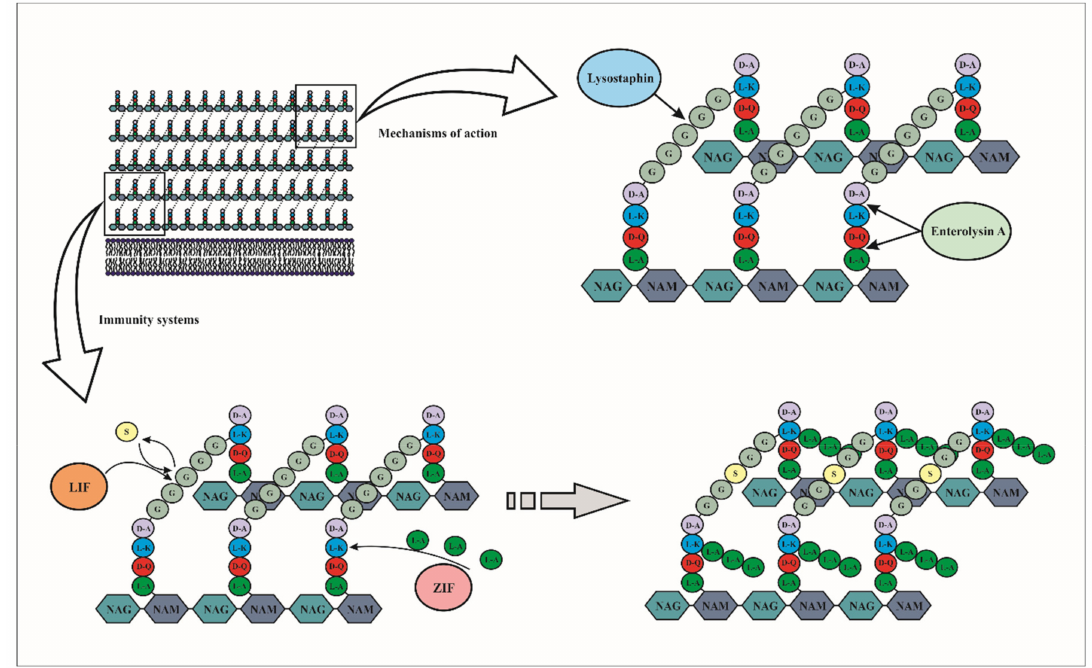
Figure 6. Mechanism of action and immunity of class III bacteriocins on the bacterial wall. These bacteriocins are endopeptidases that act on the bacterial cell walls. Lysostaphin cleaves specifically between the third and fourth glycine residues of the pentaglycine cross-bridge, while Enterolysin A cleaves interpeptide bonds inside peptidoglycan units between L-alanine and D-glutamic acid. Regarding the immunity, the Lif and Zif proteins add or modify the cross-bridged amino acids during the synthesis of peptidoglycan subunits in the cytoplasm. Therefore, the Zif protein increases the proportion of cross-bridges containing three L-alanines, while the Lif proteins are involved in the substitution of glycine by